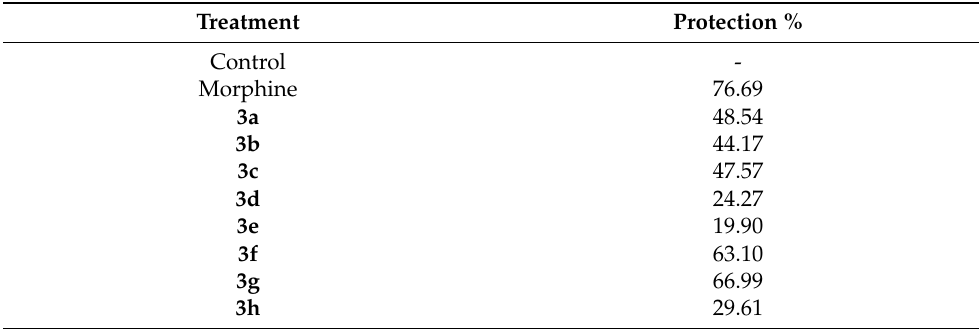
Table 2. Effects of test compounds (50 mg/kg, p.o.) and morphine (10 mg/kg, i.p.) on protection (%) values of mice in the acetic acid-induced writhing test.